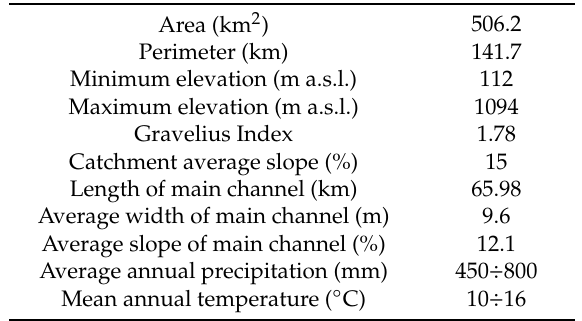
Table A2. Sub-basins candidate to be gauged and main morphologic features.